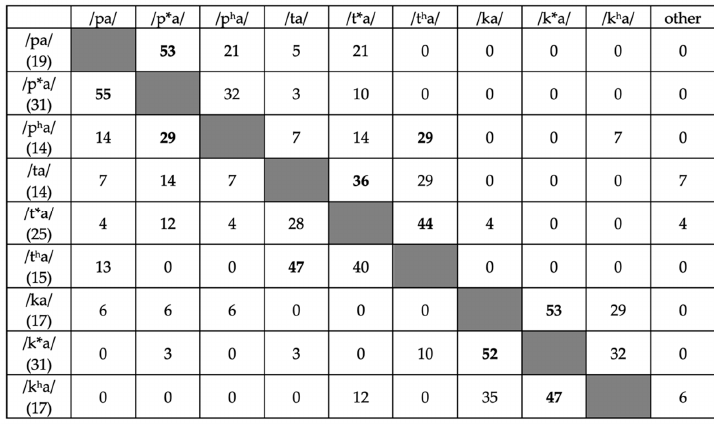
Figure A1. Confusion matrix of errors by the lead ‐ short group in the posttest for stop items (vertical = stimuli, horizontal = responses). Each cell shows the percent of all errors on the given stimulus represented by the given response (rows may not add to 100% due to rounding); the most common error type for each stimulus is bolded. The total number of errors for each stimulus (across all participants in the group) is shown in parentheses.